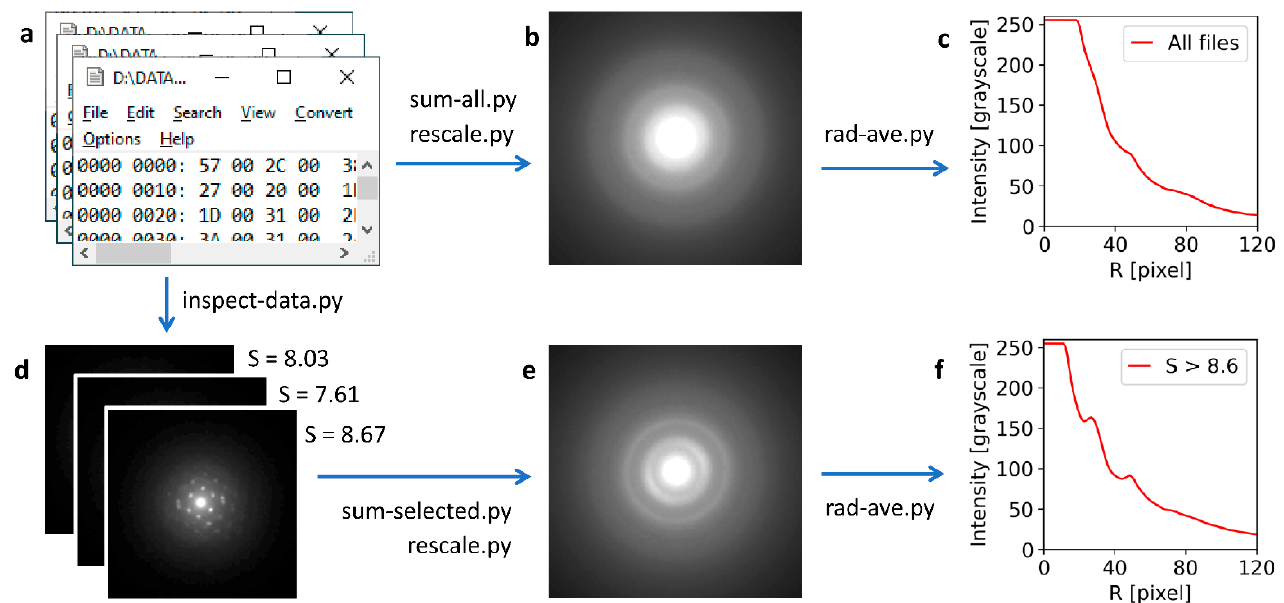
Figure 6. The processing of 4D-STEM/PNBD data by means of the STEMDIFF program package. The data come from the TbF 3 dataset. ( a ) Input binary files containing raw data from pixelated detector in the form of 256 × 256 array, ( b ) the composite powder diffractogram created by the summation of all files by means of scripts sum-all.py and rescale.py , ( c ) the radially averaged intensity, created by script rad-ave.py , ( d ) the individual diffractograms with the corresponding calculated values of Shannon entropy, S , which can be gradually visualized by means of script inspect-data.py , ( e ) the composite powder diffractogram created by the summation of the diffractograms with high values of Shannon entropy (here: S > 8.6), created by scripts sum-selected.py and rescale.py , and ( f ) the radially averaged intensity, created by script rad-ave.py